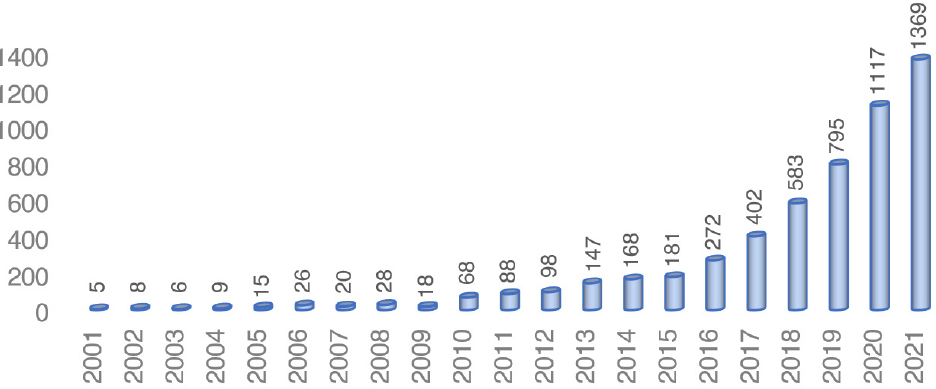
Fig. 4. Cumulative publication: augmented reality AND learning